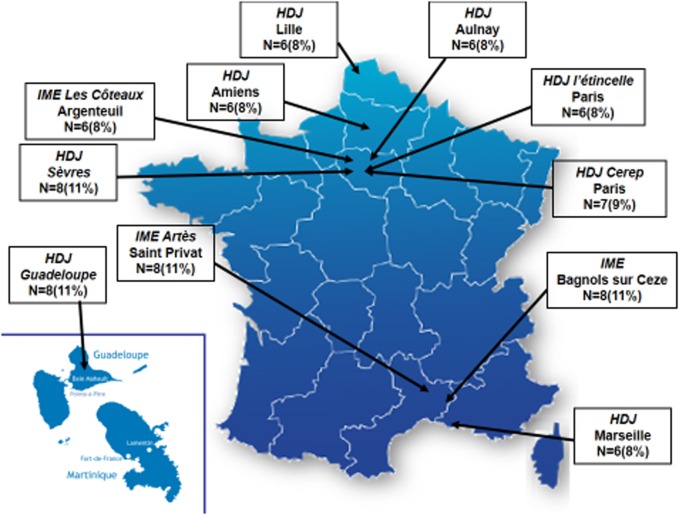
Institutions and participants’ enrollment in the DS1-EI trial by site. HDJ, Hopital de Jour (Day care medical center); IME, Institut Medico-Educatif (Special education center).